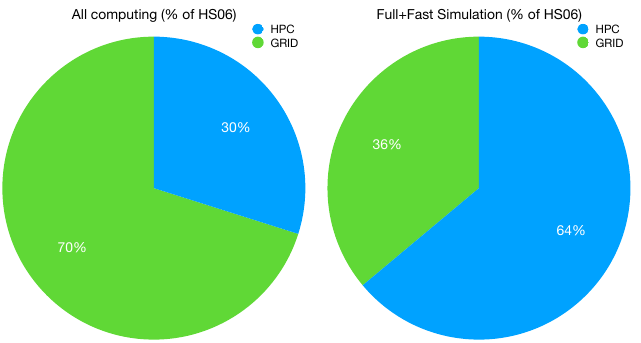
Figure 2. Left: Proportion of HS06 (s) provided by GRID resources (green) and the MareNostrum 4 HPC (blue) in total contribution to the ATLAS computing by the Spanish cloud in 2020. Right: Proportion of HS06 (s) provided by GRID resources (green) and the MareNostrum 4 HPC (blue) only in simulation jobs during 2020 in Spain.